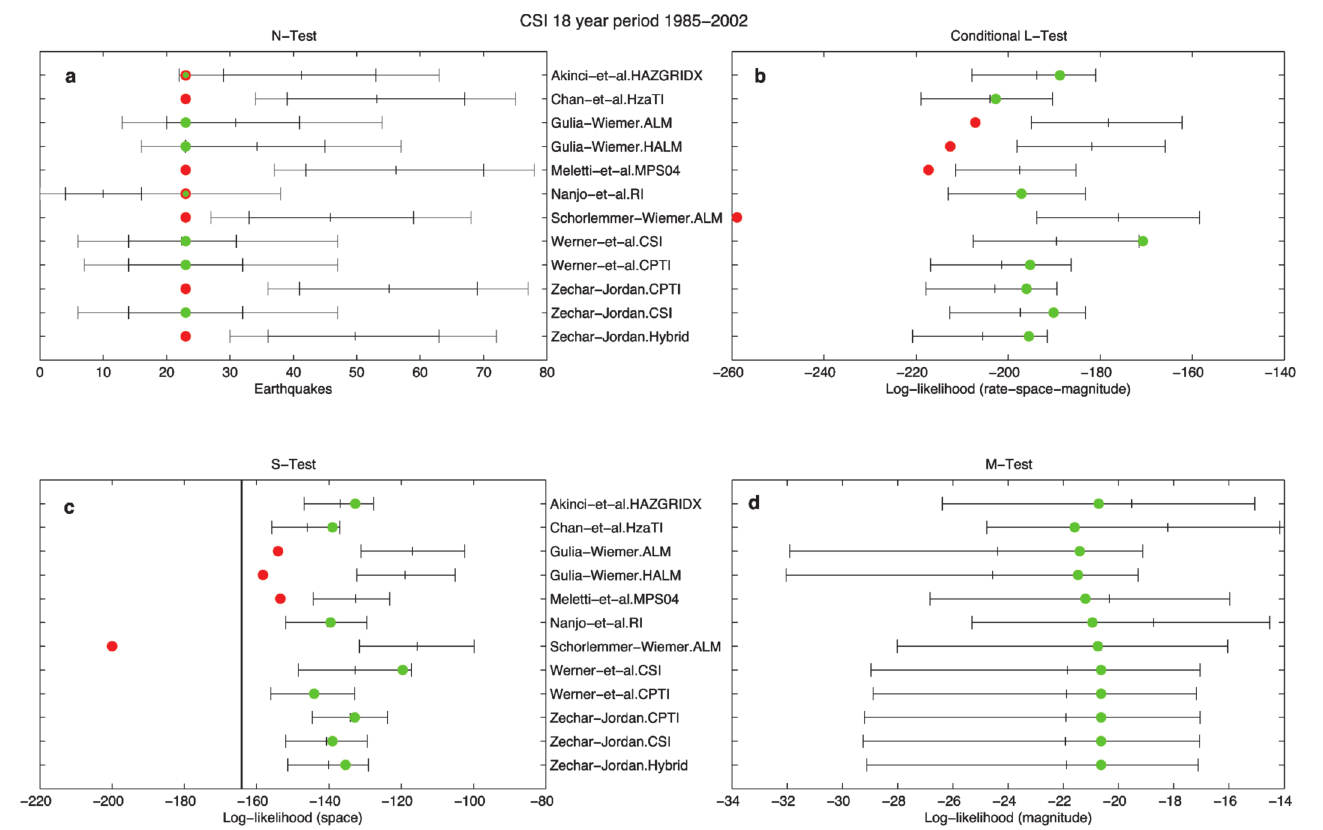
Figure 5. Results of the (a) N-Test, (b) conditional L-Test, (c) S-Test, and (d) M-Test of the scaled 10-year time-independent forecasts using the 18-year target period from 1985 to 2002 of the data from the CSI. Symbols and bars as given in the legend to Figure